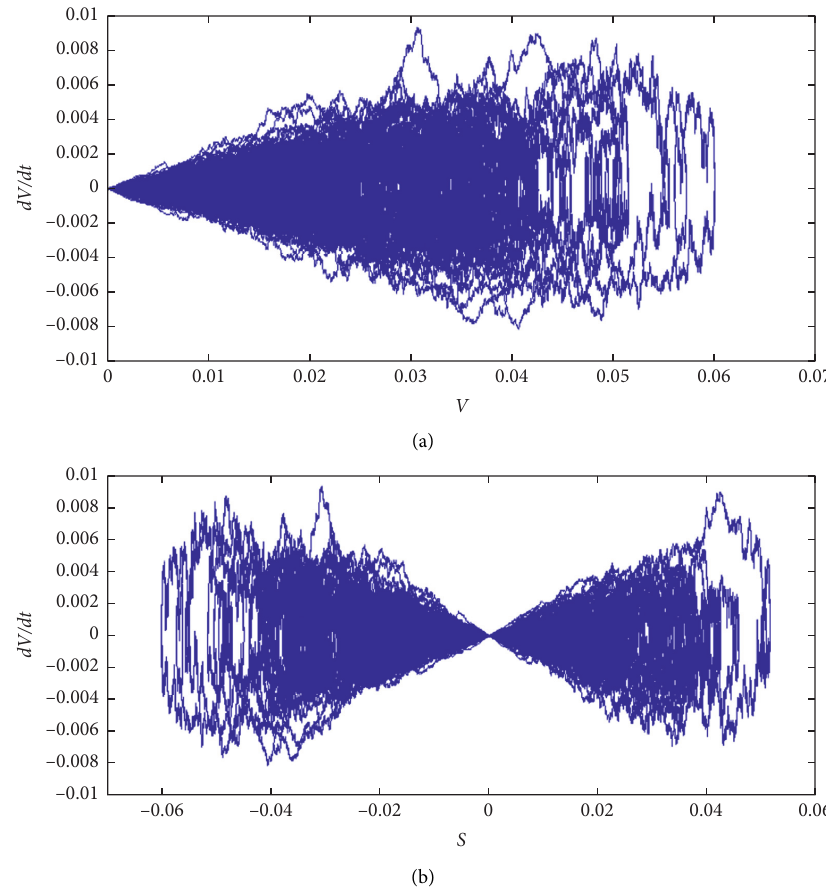
Figure 15: Variation of d V /d t versus V and s for the uncontrolled system. (a). d V /d t versus V and (b). d V /d t versus s